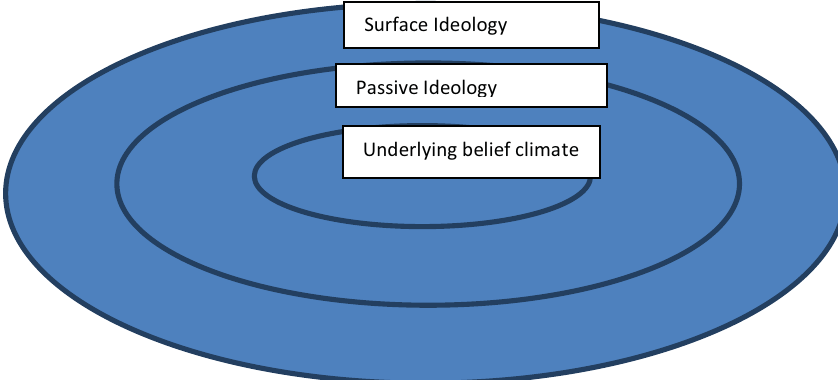
(Colour online) Hollindale’s three levels of